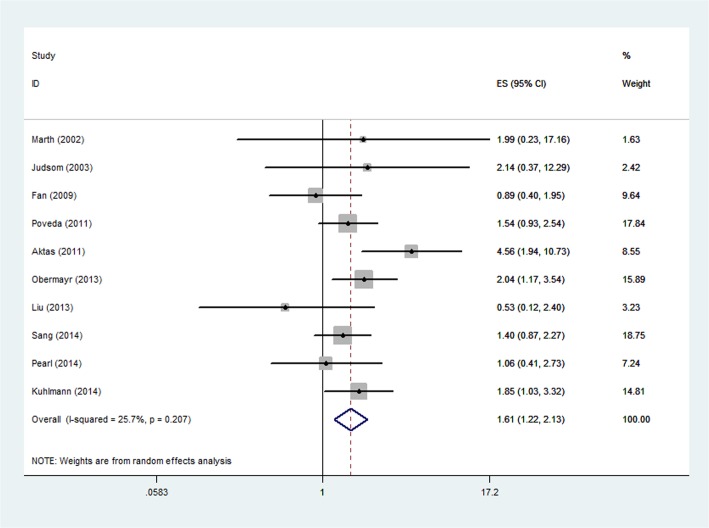
Forest plot showing the meta-analysis of hazard ratio estimates for OS in overall patients.OS = overall survival.